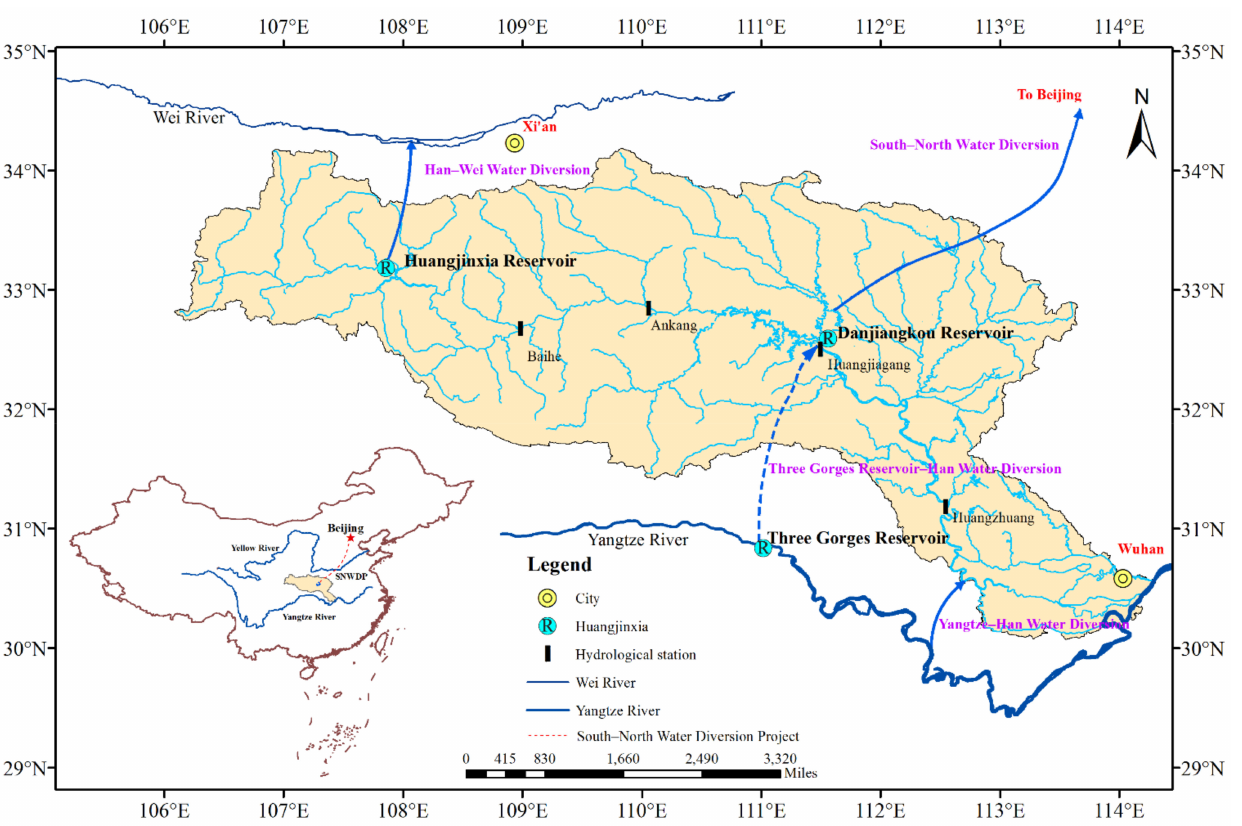
Figure 1. Geographic location of the Han River basin and water division